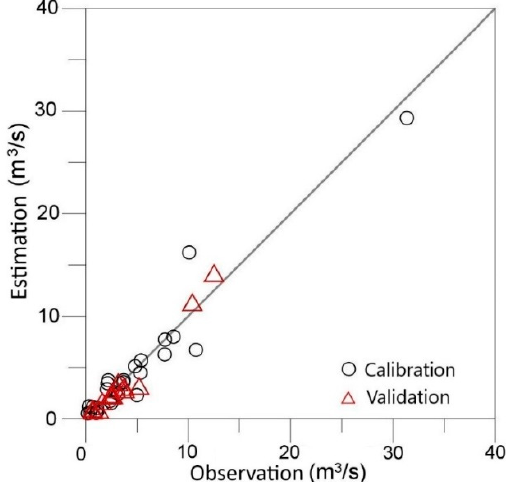
Figure 8. Observed and estimated watershed average streamflow discharge.